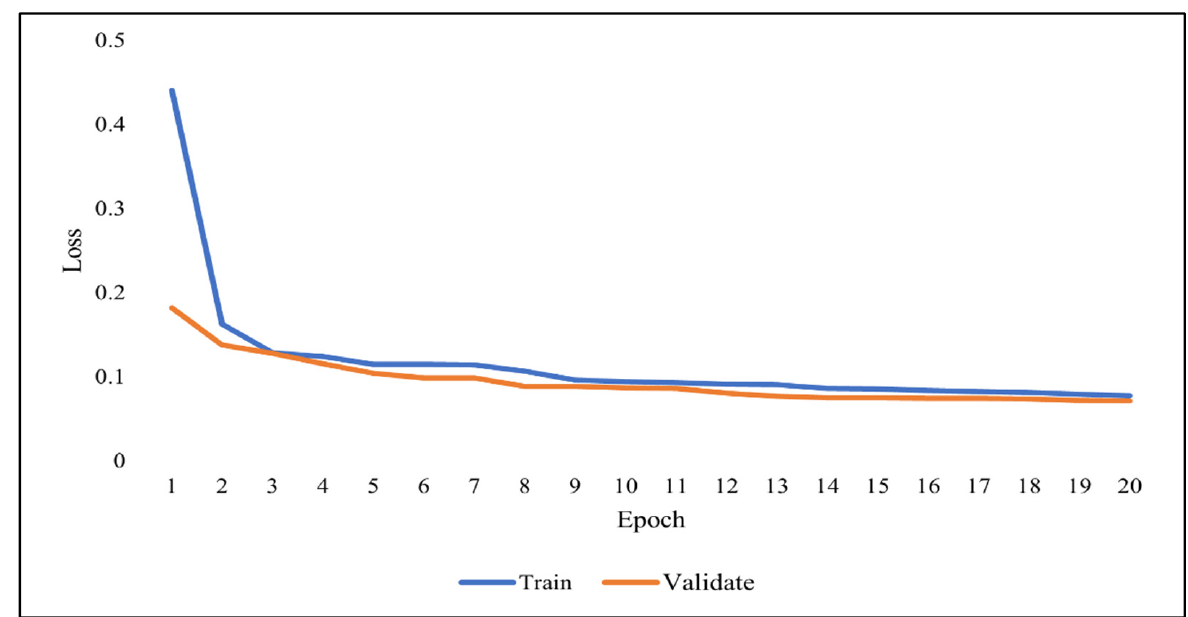
Figure 9. CNN learning curve during training.